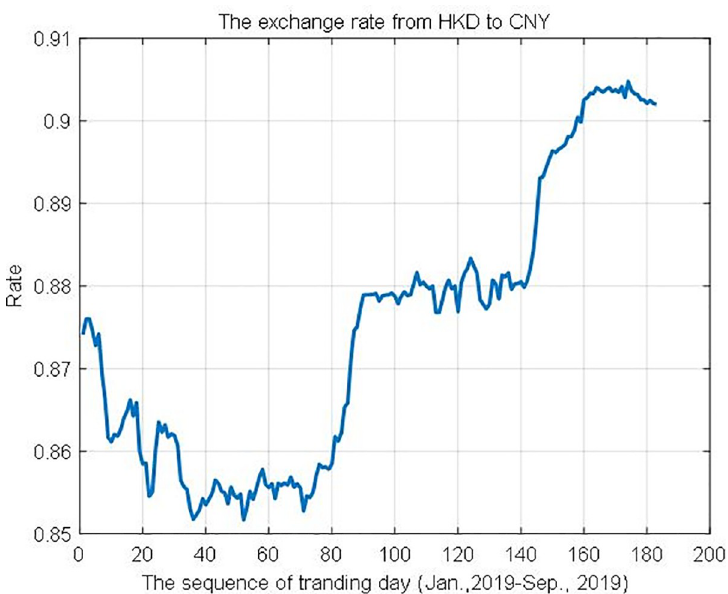
Fig 8. The real-time exchange rate from HKD to CNY